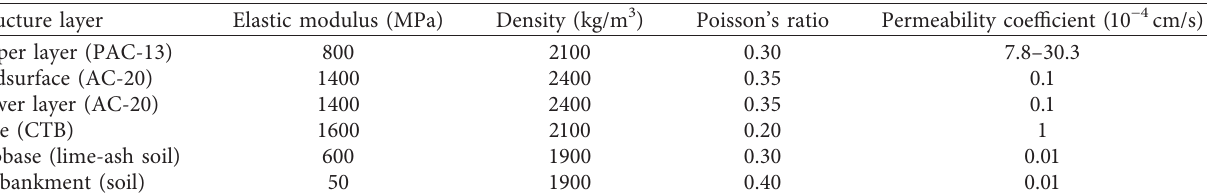
Figure 6: The internal Table 6: Material parameters of the model structure.